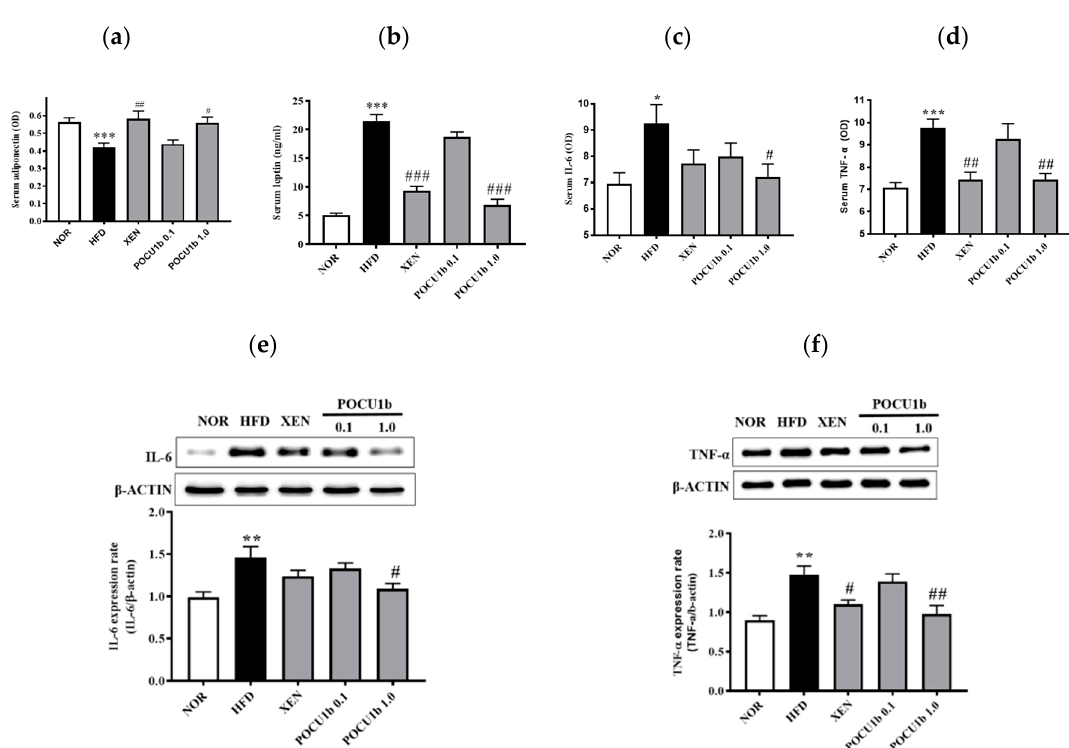
Figure 7. Effects of POCU1b on levels of adiponectin, leptin, IL ‐ 6, and TNF ‐α in the serum and/or liver in HFD ‐ fed rats. ( a ) Serum adiponectin and ( b ) leptin levels. ( c ) IL ‐ 6 level in the serum and ( e ) expression in the liver. ( d ) TNF ‐α level in the serum and ( f ) expression in the liver. Serum adiponectin, leptin, insulin, TNF ‐α , and IL ‐ 6 levels were quantified using commercial ELISA kits. Protein expression was measured by Western blot analysis. * p < 0.05, ** p < 0.01, *** p < 0.001 vs. NOR, # p < 0.05, ## p < 0.01, ### p < 0.001 vs. HFD.